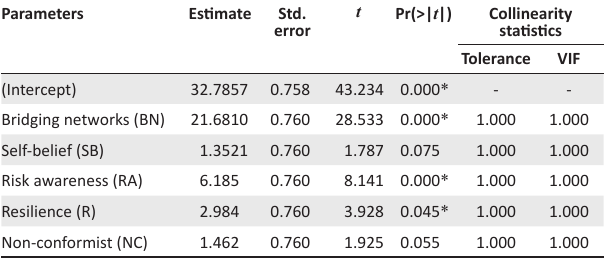
TABLE 3: The significant endogenous variables influencing small and micro scale enterprises success ( n = 280).